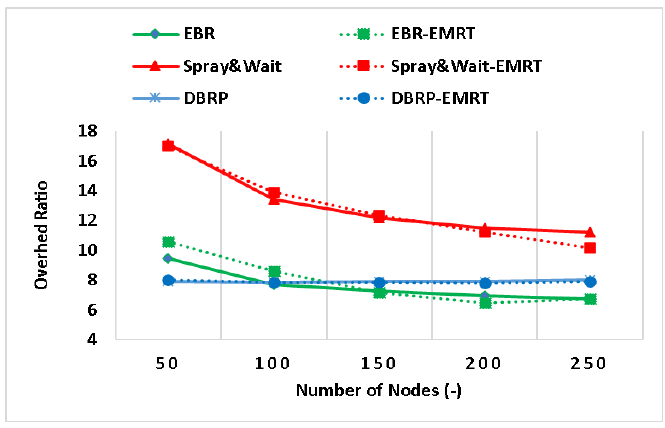
Figure 3. The overhead ratio with different node densities.